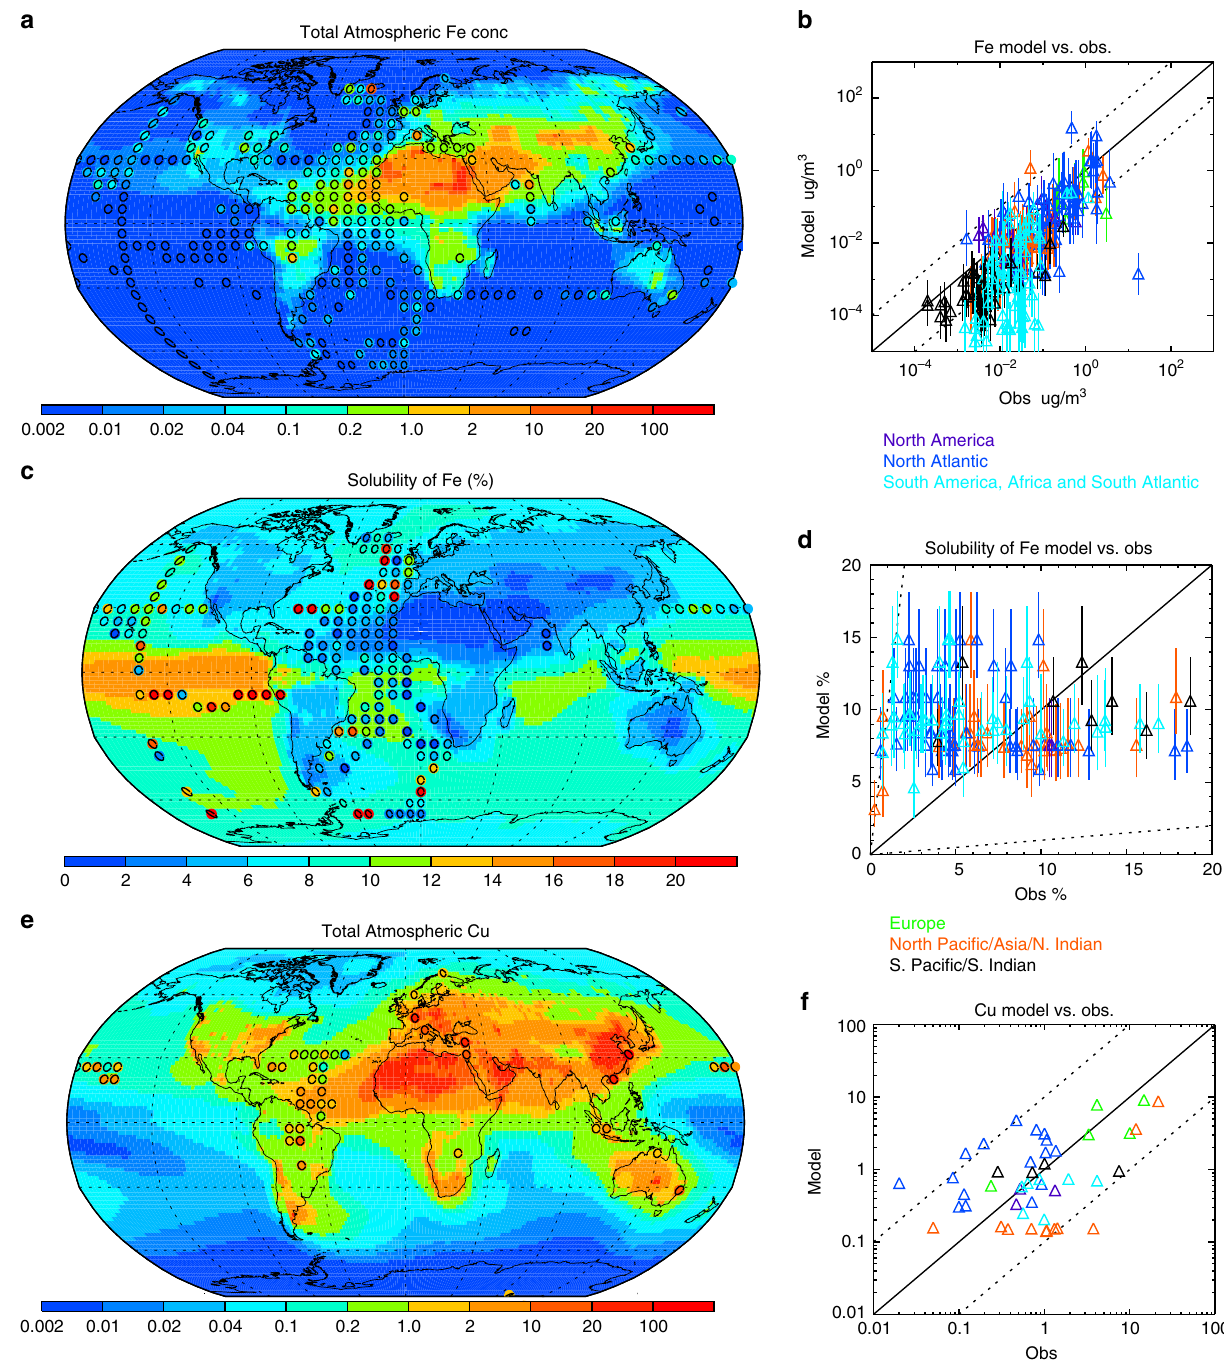
Fig. 4 Spatial distribution of metals in aerosols. Distribution of iron concentrations (R. Scanza et al. (manuscript in preparation) and ref. 160 ) ( a ), iron solubility (R. Scanza et al. (manuscript in preparation) and ref. 160 ) ( c ), and copper concentrations 10 ( e ) in models and observations. Iron solubility in measurements in the atmospheric aerosols ( a ) and modeled values ( b ), and scatter plot comparing the observations versus the model for total iron ( b ), solubility of iron ( d ), and copper ( f ). Vertical bars in b , d represent one standard deviation above and below the annual mean values, based on daily averages within a chemical transport model. The mean and standard deviation are calculated in log-normal space, as the distribution of the values is closer to a log-normal distribution than a Gaussian distribution